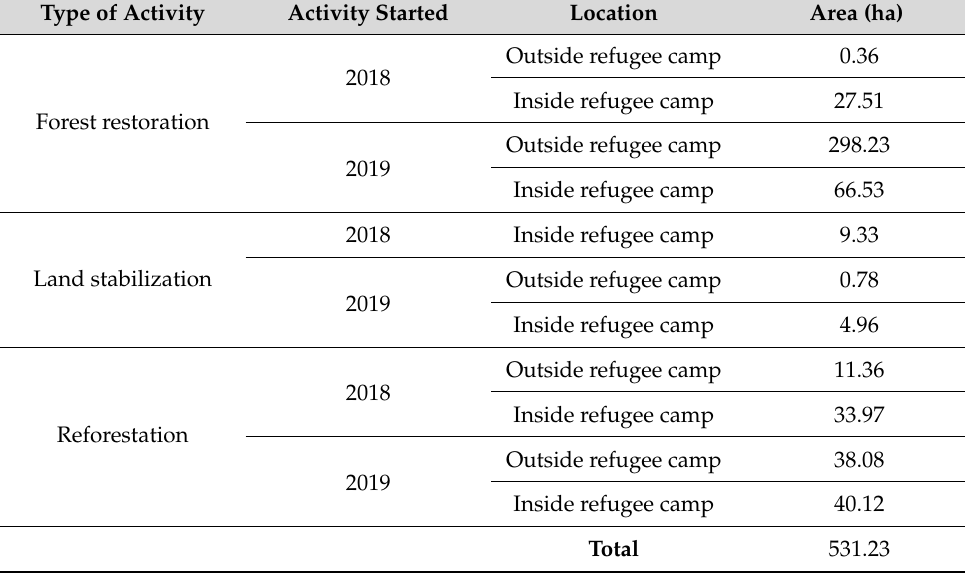
Table 2. Area distribution and location of different restoration